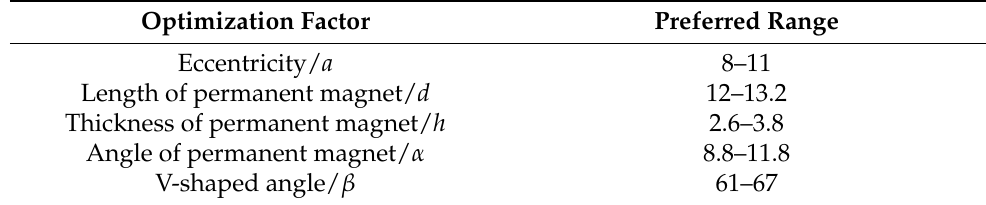
Table 5. Selection range of optimization parameters.